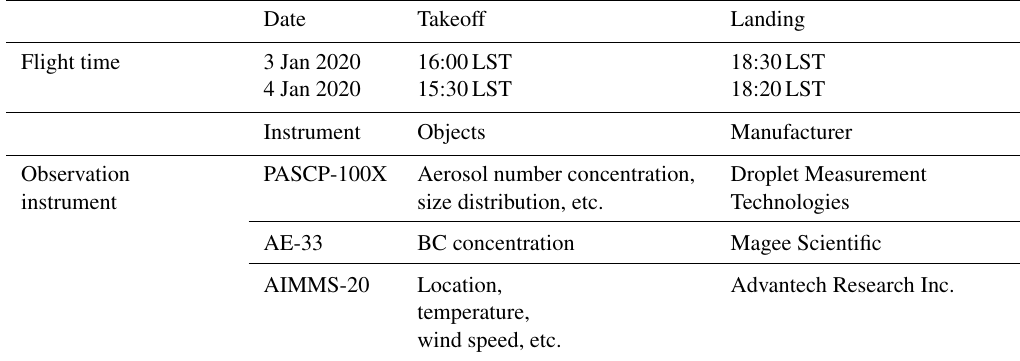
Table 1. Information of the King Air 350 aircraft flight times and instruments. LST is local sidereal time.